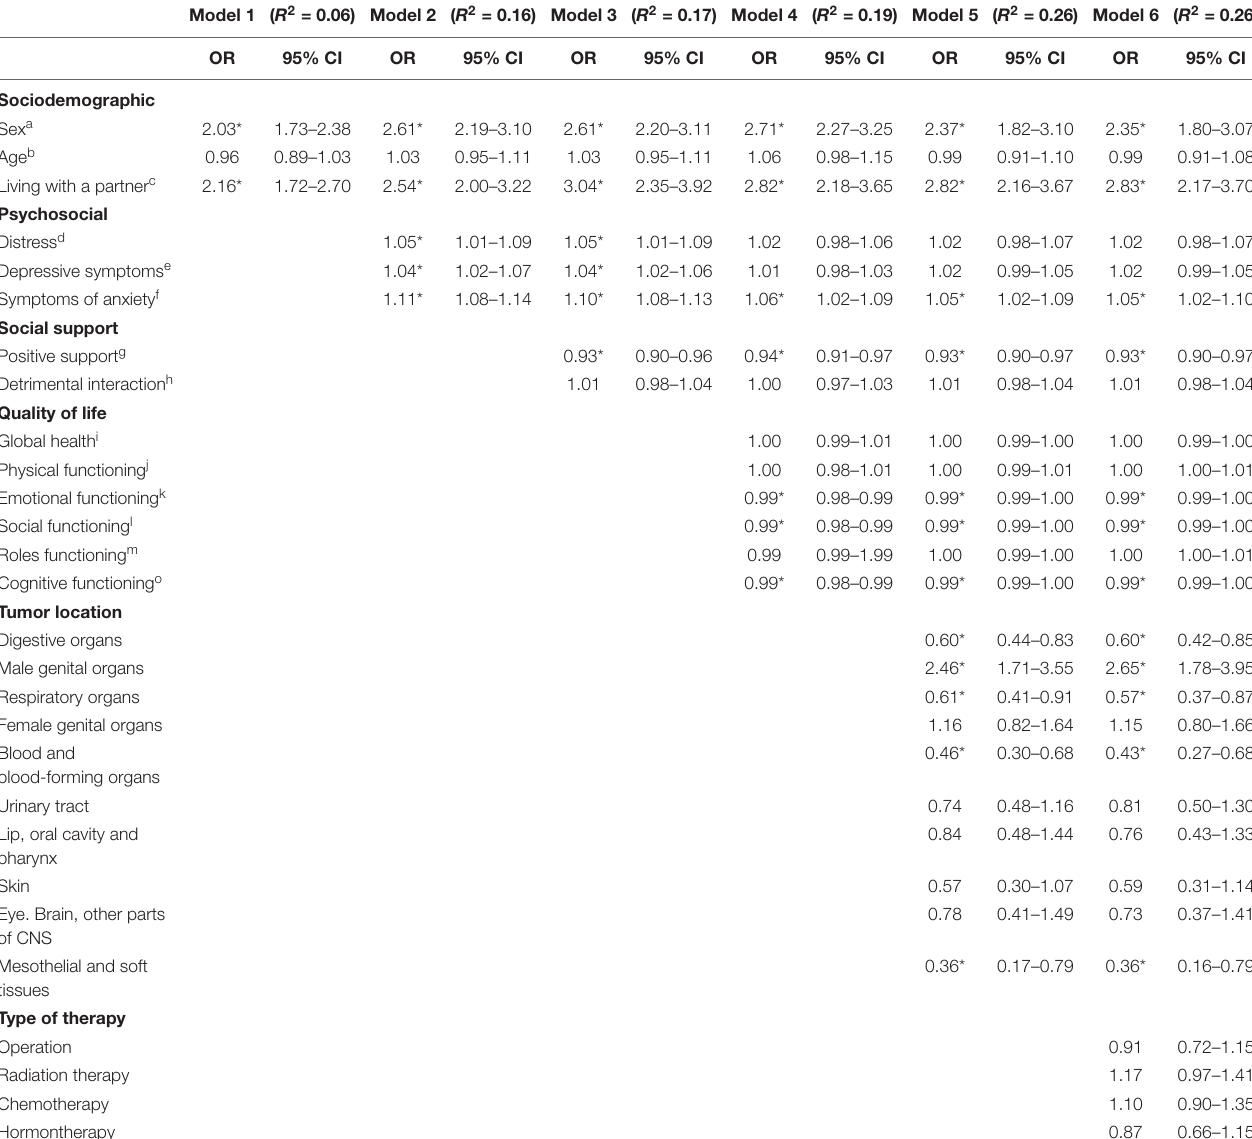
TABLE 3 | Multivariate hierarchical logistic regression of sexual problems with sociodemographic and psychosocial factors as